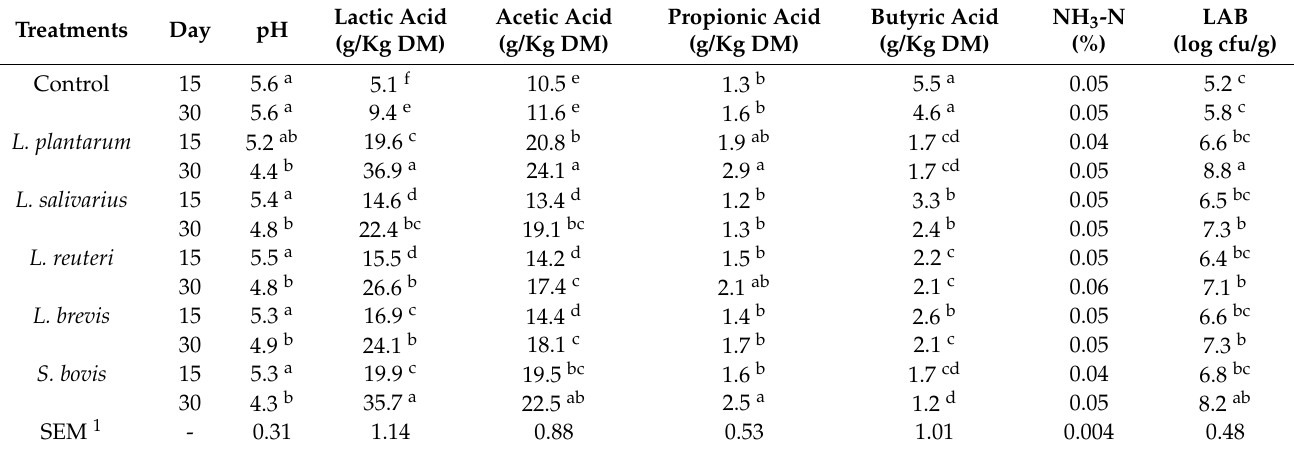
Table 4. Effects of inoculation of LAB on fermentation quality of ensiled rice straw.